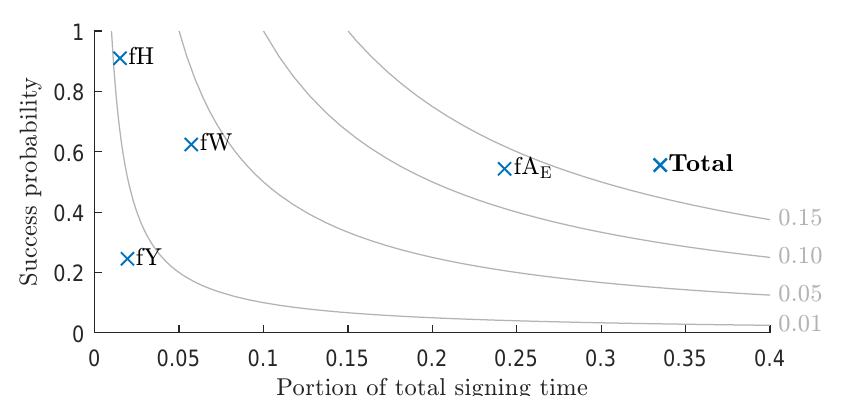
Figure 3: Comparison of scenarios regarding runtime as portion of total signing time (from Table 5) vs. success probability (from Table 4). Lines of constant product are drawn in solid